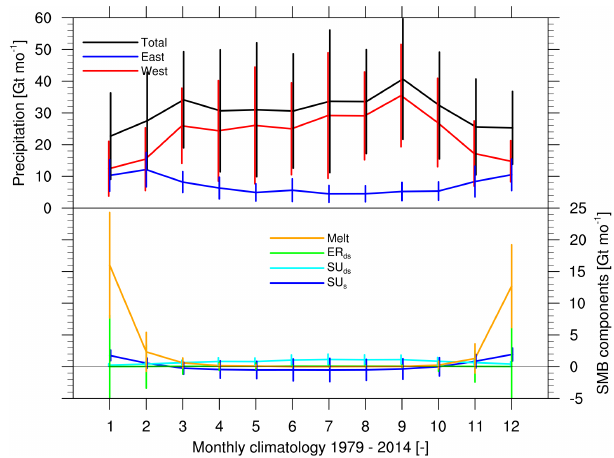
Figure 9. 1979–2014 monthly climatology of SMB components: top panel shows total precipitation (snowfall + rain) averaged for the WAP drainage basins (red line), the EAP (blue), and total (black). Bottom panel shows total (WAP + EAP) snowmelt (or- ange), erosion of drifting snow ER ds (green), drifting snow subli- mation SU ds (cyan), and surface sublimation/deposition (blue). All variables in Gtmo − 1